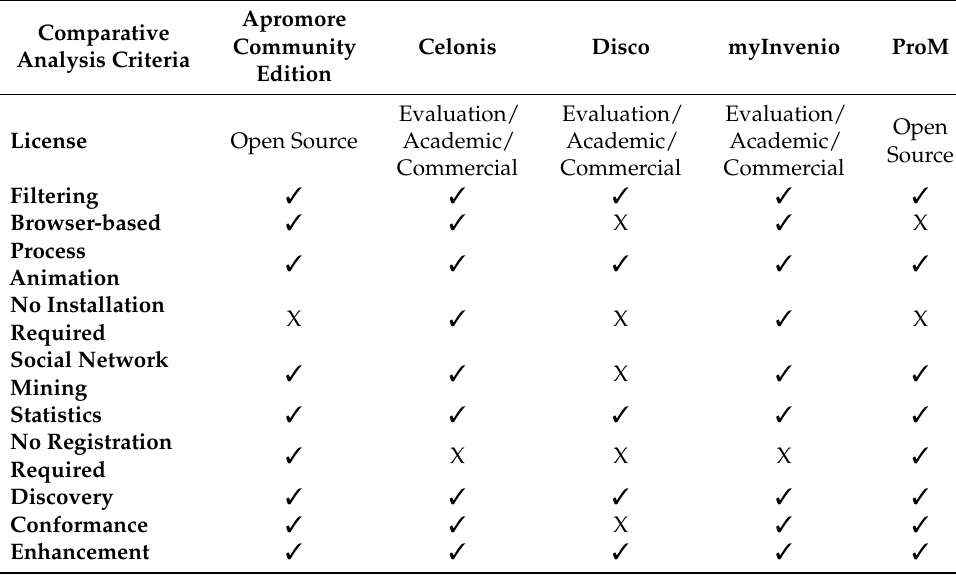
Table 4. Overview of software tools ( (cid:51) = yes, X = no). Comparative Analysis